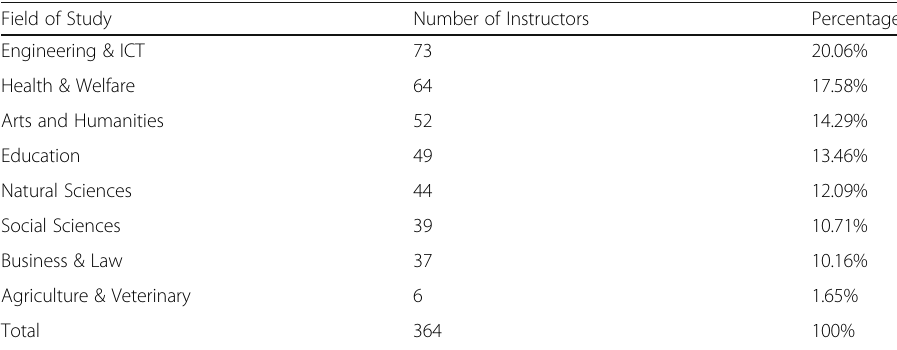
Table 1 Demographic distribution of respondents based on field of study Field of